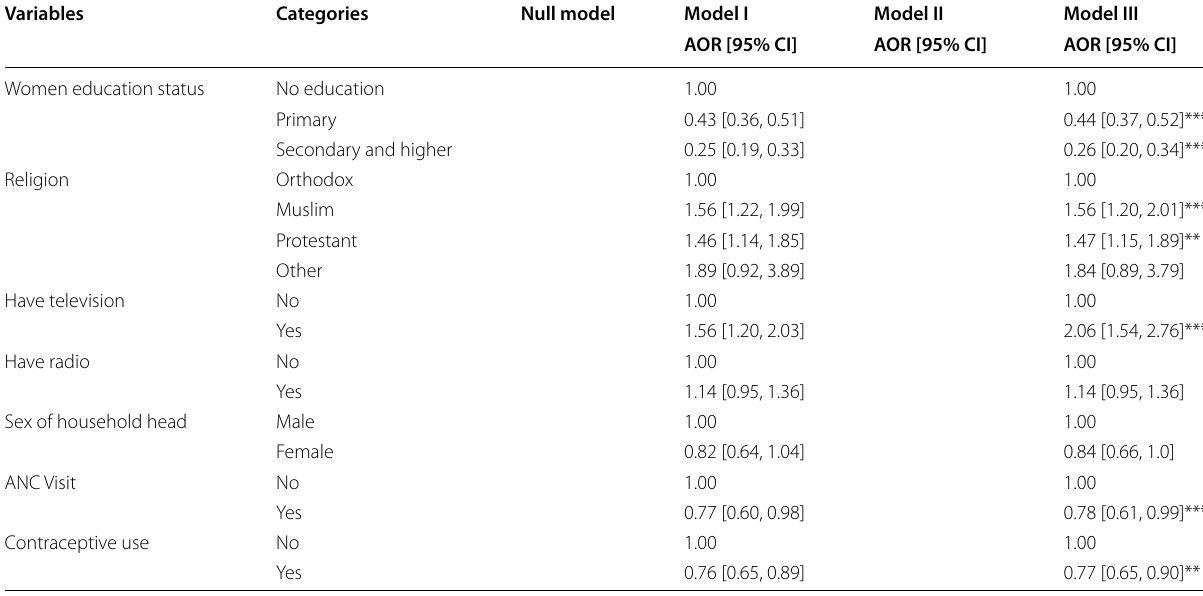
Table 3 Multilevel multivariable analysis of factors associated with high-risk fertility behavior among reproductive-age women in